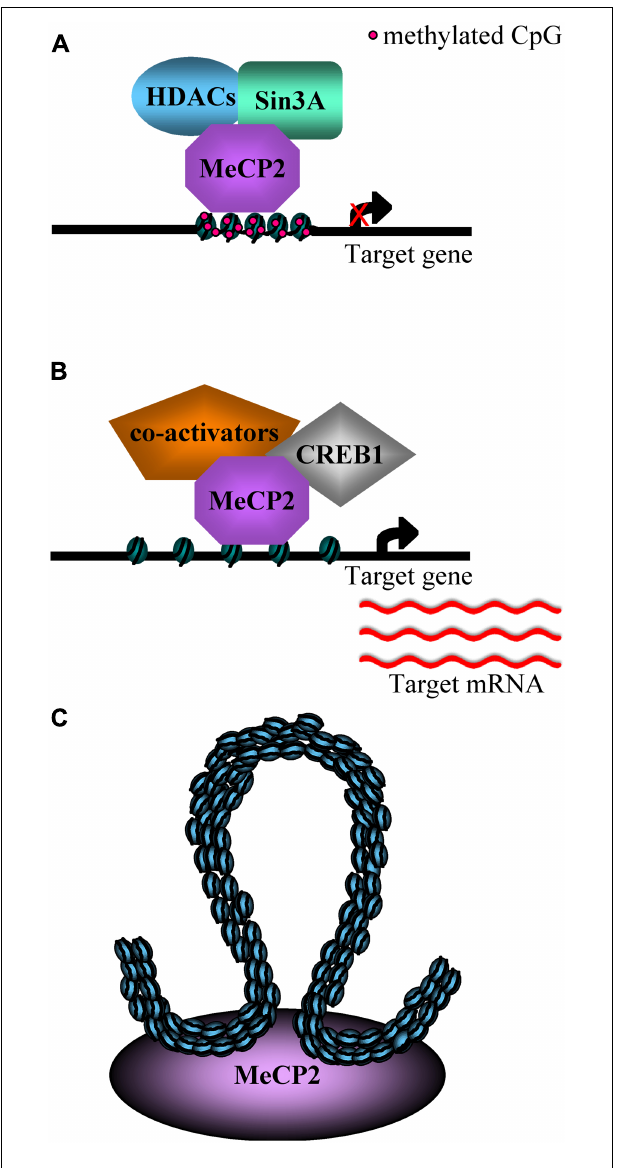
FIGURE 1 | (A) An example of MeCP2 mediated transcriptional repression: the methyl-DNA binding domain (MBD) binds methylated CpG sites and recruits histone deacetylases and co-repressors (Sin3A), inducing chromatin compaction and gene silencing (Nan etal., 1998; Chen etal., 2003; Klose and Bird, 2003). (B) MeCP2 is able to activate the transcription of some genes in hypothalamus, by binding unmethylated promoters and recruiting CREB1 and, potentially, co-activators (Chahrour etal., 2008). (C) MeCP2 is responsible for the silencing of Dlx5/6 imprinted locus by inducing the formation of a silent higher order chromatin loop (Horike etal.,